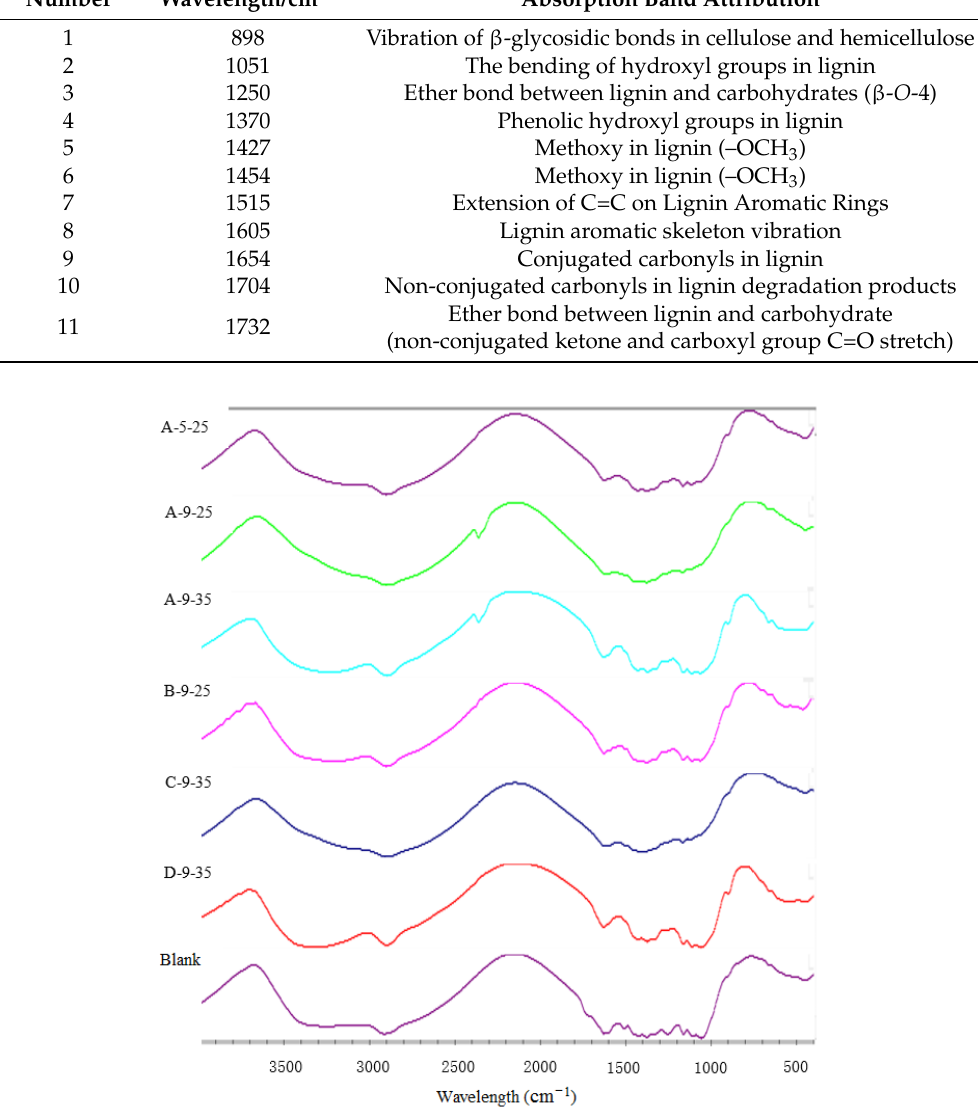
Table 3. Assignments of characteristic absorption of samples.